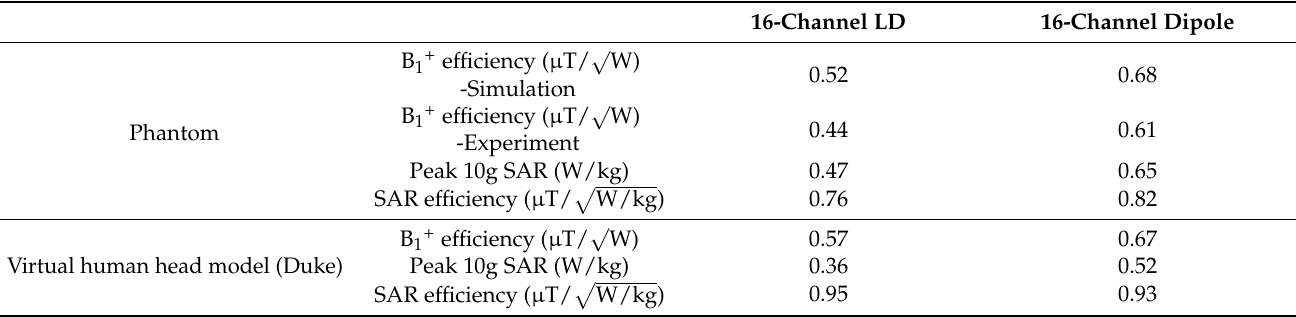
Table 2. Summary of B 1+ efficiency, peak 10 g specific absorption rate (SAR), and SAR efficiency between the 16-channel dipole and LD arrays with a phantom and a human model in the region of interest (ROI) positioned on the highest value. The experimental data were obtained only for the B 1 + efficiency in the phantom. 16-Channel LD 16-Channel